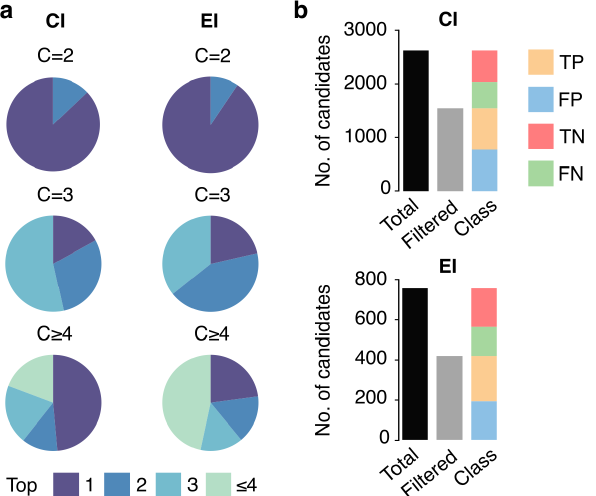
Figure 4. Metabolite identity candidates ranking and filtering using predicted RI in EI and CI. ( a ) Percentage of correctly identified metabolites with 2 (C = 2), 3 (C = 3), or 4 or more (C ≥ 4) putative candidates ranked according to predicted-reference RI error. ( b ) Total number of metabolites (black), number of filtered metabolites using a 3% RI threshold (gray) and candidate classification as True Positives (TP), True Negatives (TN), False Positives (FP) and False Negatives (FN) using the same